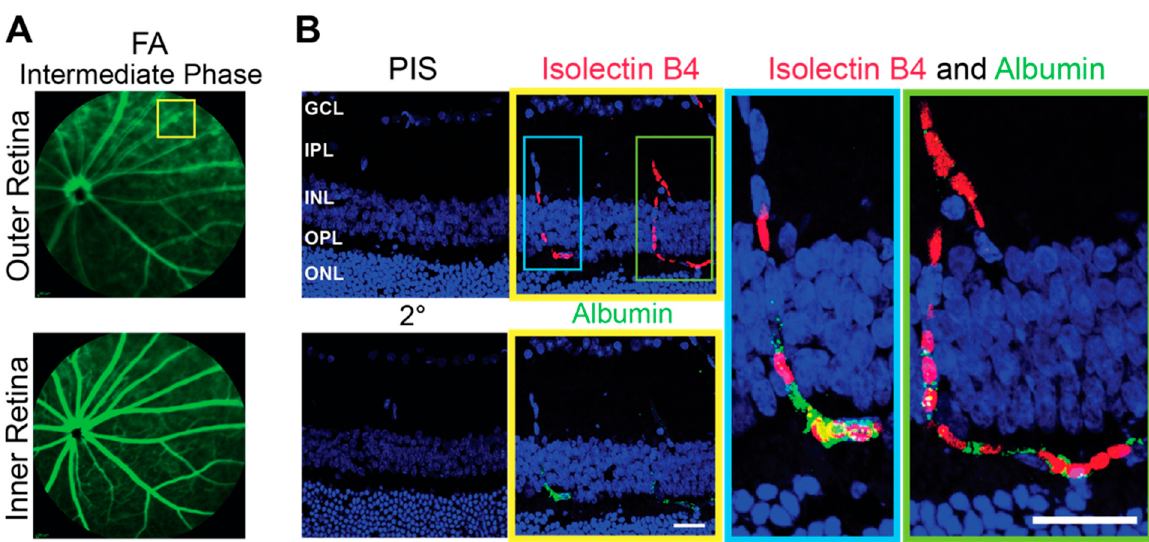
Figure 5. Increased permeability of the retinal blood vessels in hamsters. ( A ): Representative image (4 females and 3 males either with structurally normal or abnormal retinas, the staining pattern was the same) of a fundus fluorescein angiography (FA) showing an area (yellow box) of increased vasopermeability in the outer retina. ( B ): The boxed area in ( A) as assessed by control stains with pre-immune serum (PIS) and secondary antibody only (2°) and stains for the blood vessels with isolectin B4 (red) and albumin (green). Nuclei were stained with DAPI. The magnification of the cyan and green boxed regions in the latter two are also shown. The retinal layer labeling is as described in Figures 1 and 2. Scale bars = 25 µm.